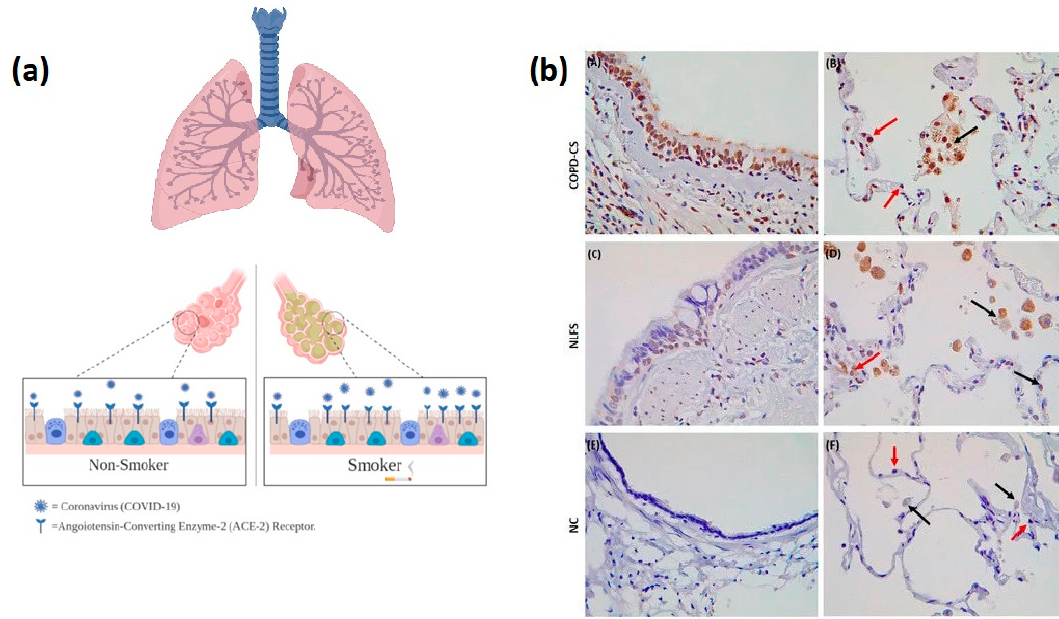
Figure 1. ( a ) Effect of smoking on angiotensin-converting enzyme-2 (ACE) receptors and its relationship to COVID-19: smoking may increase the number of ACE receptors, which leads to an increase in the severity and rate of COVID-19 infection. ( b ) The first immunohistochemical human lung evidence for ACE2 receptor expression in smokers and patients with chronic obstructive pulmonary disease (COPD). Current smoker with COPD, ( A ) indicating positive staining in the small airway epithelium but also apical including cilia ( B ) red arrows showing positive staining in type-2 pneumocytes and black arrows indicating alveolar macrophages positive for the ACE2 receptor. Normal lung function smoker (NLFS), ( C ) and ( D ) representing similar pattern for COPD although a little less staining is observed. Normal controls (NC), ( E ) and ( F ) no staining observed in any of the areas. Taken with permission from [10].